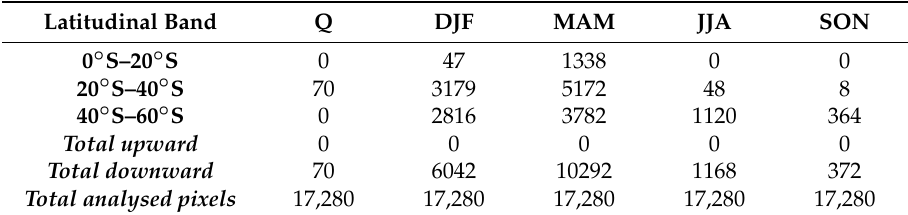
Table 5. As in Table 1 but for the NO 2 concentrations in the